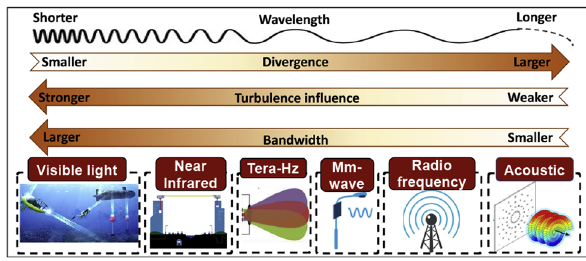
Figure8: Orbitalangularmomentum(OAM)applicationsindifferent frequencies